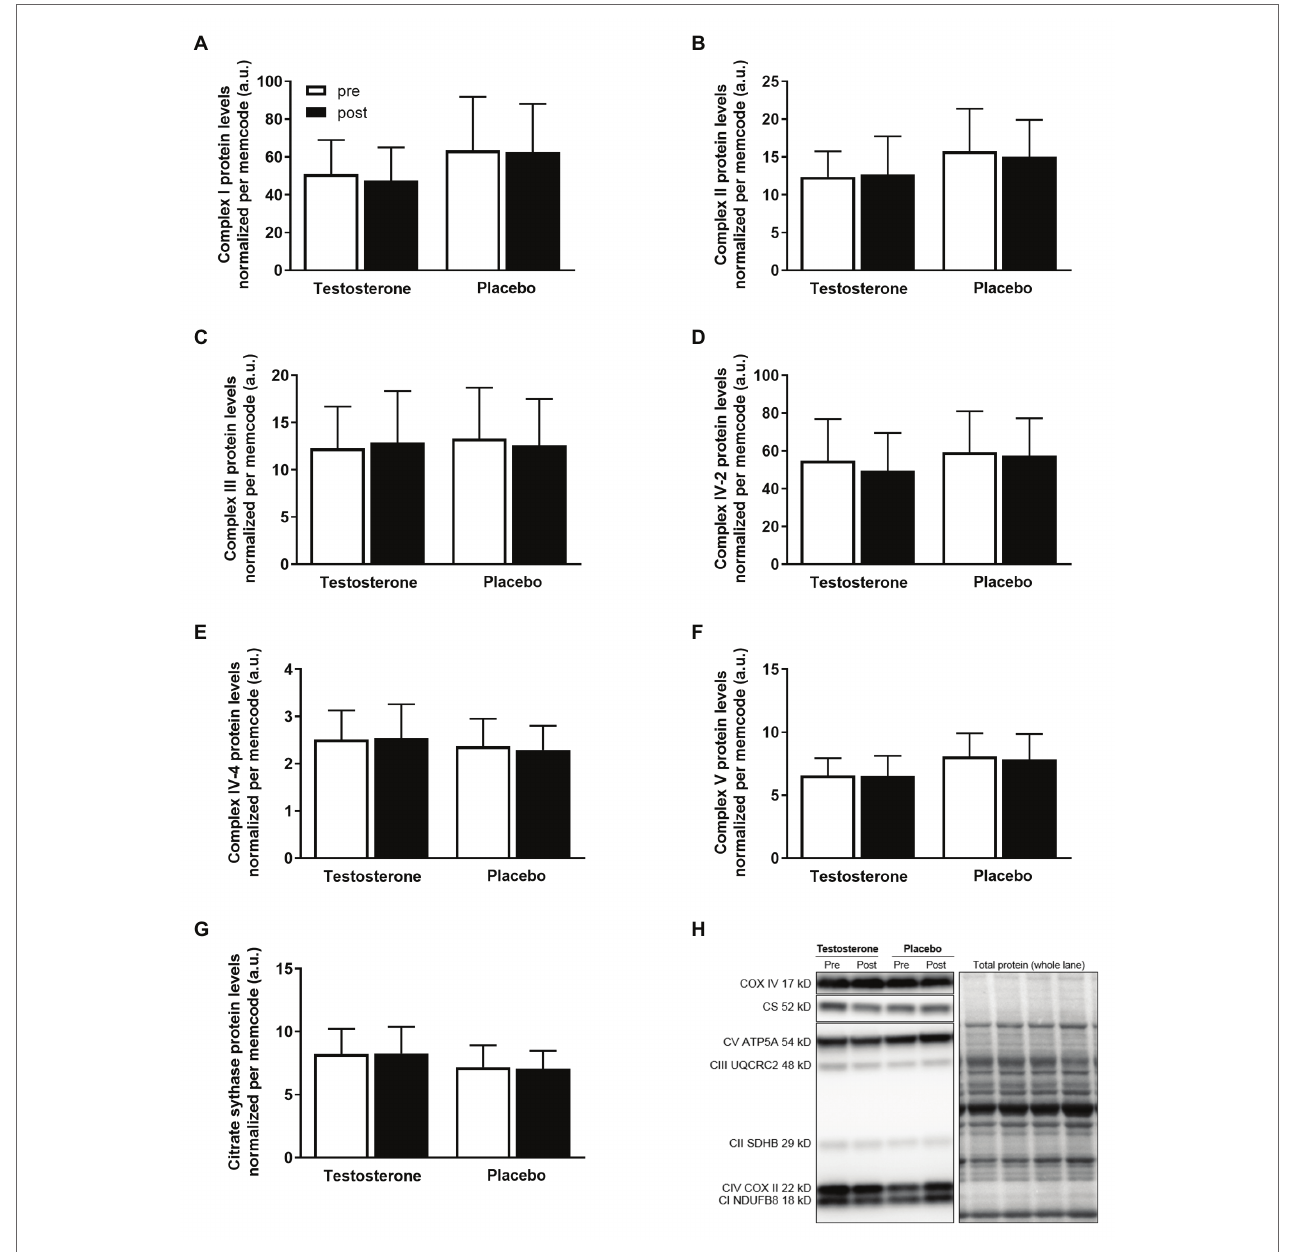
FIGURE 3 | Protein levels of complex I (A) , complex II (B) , complex III (C) , complex IV-subunit 2 (D) , complex IV-subunit 4 (E) , complex V (F) , and representative blots (G) pre (white bars) to post intervention (black bars) in the testosterone ( n = 18) and placebo ( n = 17) groups. Data are presented as means ± SD. The target proteins (H) were expressed relative to the total lane protein stained with reversible protein stain (memcode). No between- or within-group differences were